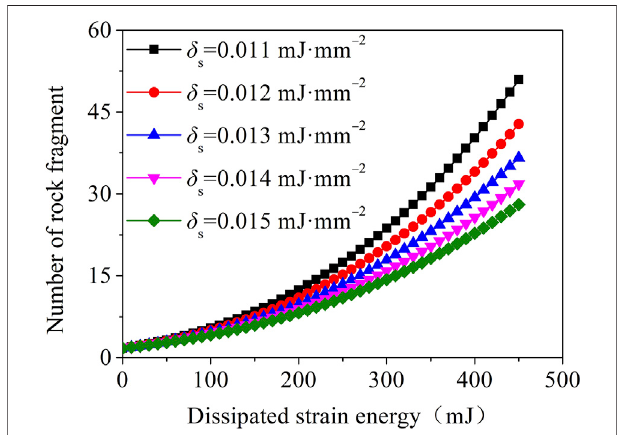
FIGURE 7 | Variation pattern of the number of rock fragments with dissipated strain energy.